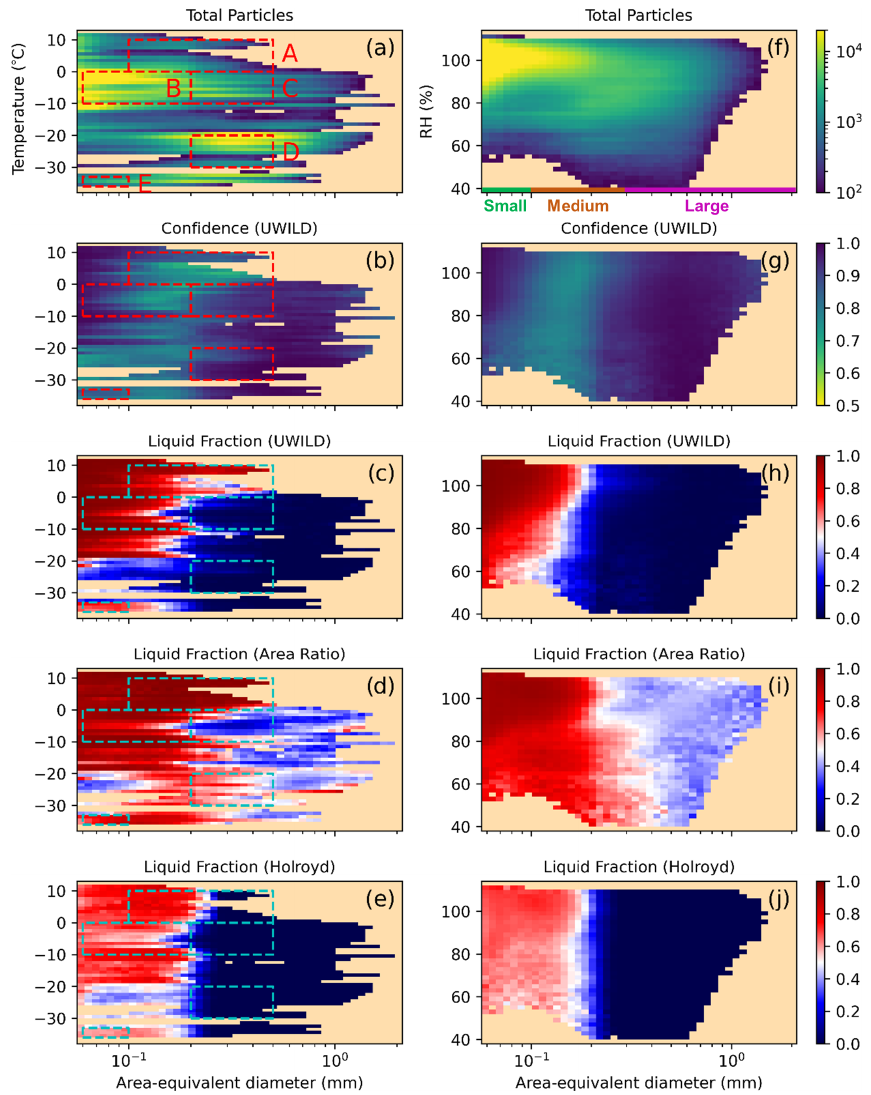
Figure 8. A 2D histogram of the number of particles meeting our criteria (row 1), UWILD confidence (row 2), and phase classifications for the three algorithms (rows 3–5) are shown in temperature–particle size phase space in the left column and relative-humidity–particle- size phase space in the right column. A threshold of 100 total particles per 2D histogram bin is used for both plots. SOCRATES flights RF01–RF14 are